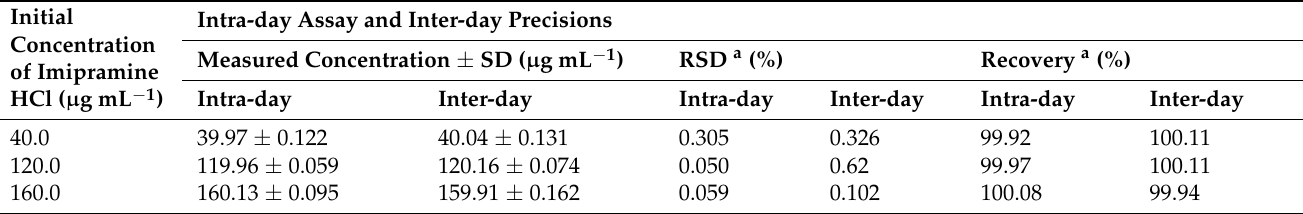
Table 7. Intra-day and inter-day precisions of the proposed HPLC method.